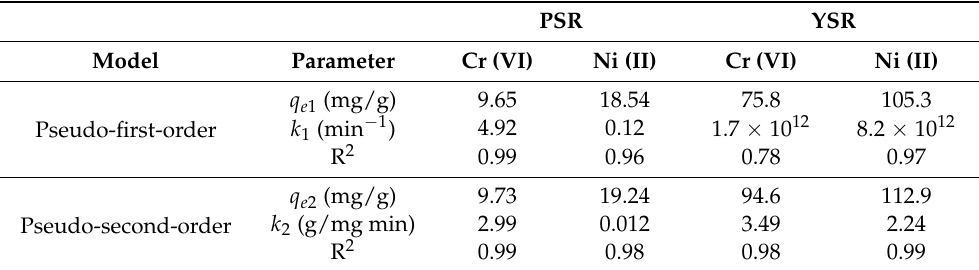
Table 8. Kinetic model fitting parameters.